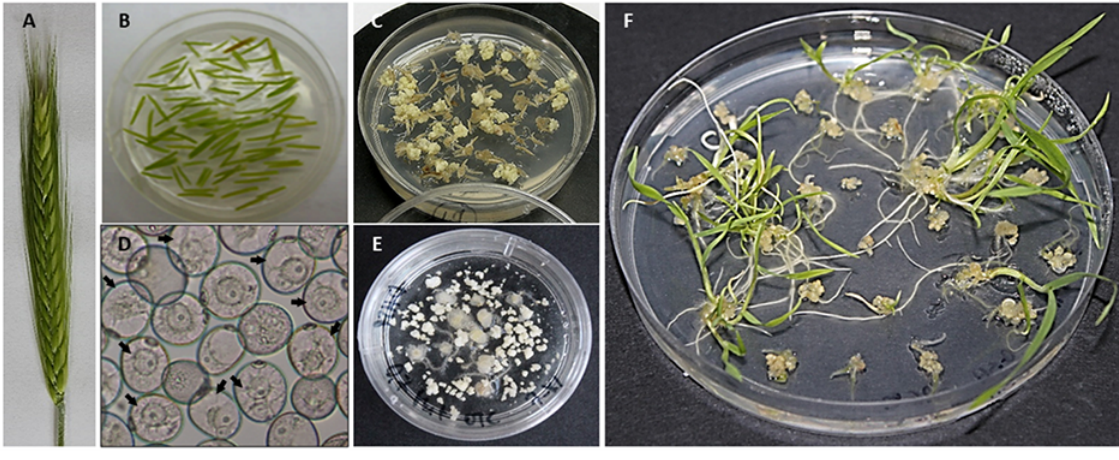
Figure 1 Microspore embryogenesis (ME) in anther culture and isolated microspore culture of triticale (× Triticosecale Wittm.). ( A ) Triticale spike at the stage optimal for ME induction. ( B ) Isolated triticale anthers transferred to the induction medium. ( C ) Embryo-like structures (ELSs) aer 6 weeks of in vitro culture. ( D ) Star-like structures (arrows) in isolated triticale microspore cultures aer transfer to the induction medium. ( E ) ELSs produced aer 6 weeks in vitro co-culture with immature ovaries. ( F ) Plantlets regenerated aer transfer to the regeneration